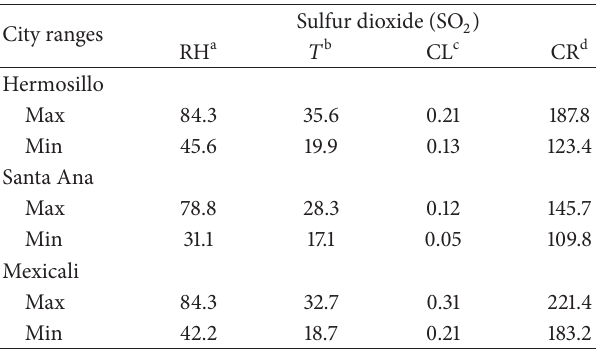
Table 3: Chemical composition (%) of MO formed within SC in industrial plant located in Mexicali as in Figure 4(a) (2011).